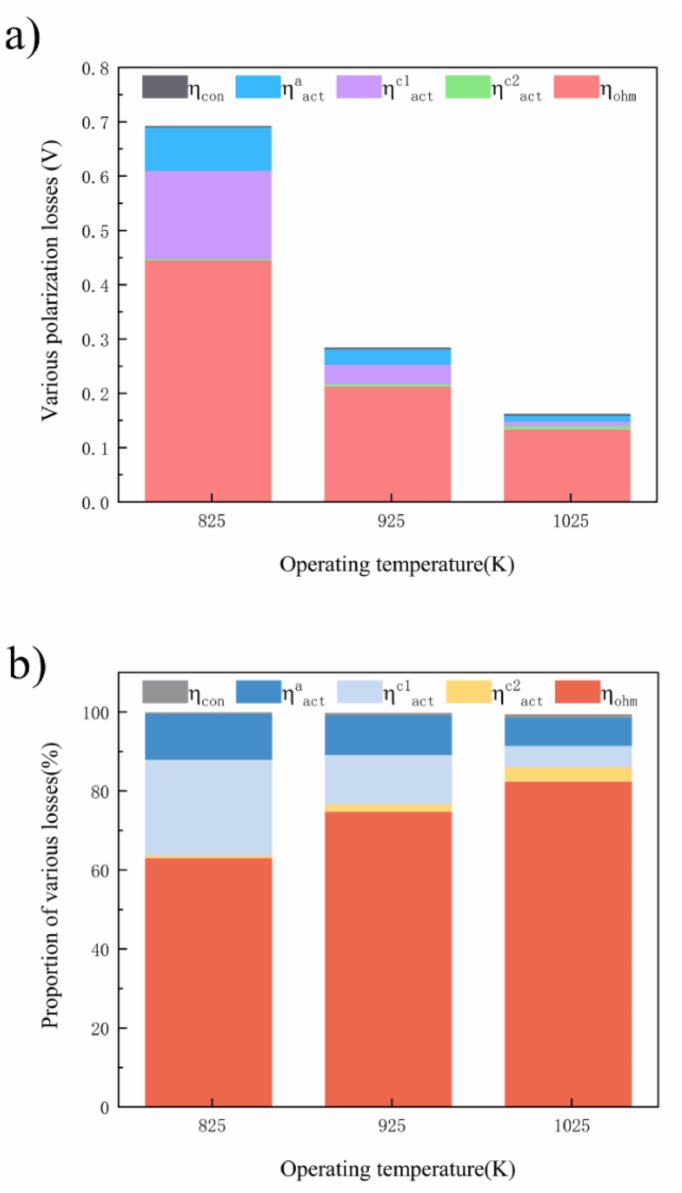
Figure 6. The contributions of different overpotentials on the total voltage loss of PCFC at different operation temperatures at ( a ) i op = 0.5 A cm − 2 and ( b ) V op = 0.5